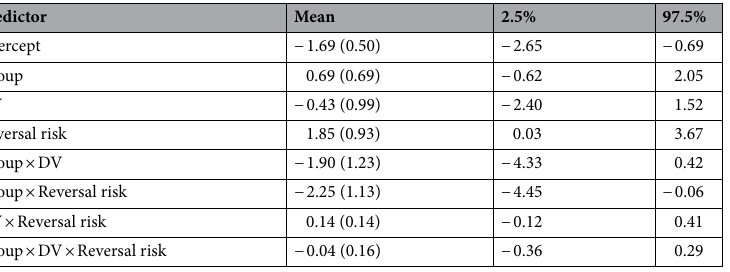
Table 4. Results of Bayesian MGLM in the precommitment task, regressing precommitment choices (0 = no precommitment, 1 = precommitment) on predictors for Group (0 = nonsmoker, 1 = smoker), difference in value (DV), reversal risk (DV in 28 days minus DV now), and the interaction terms. We report the upper and lower borders of the 95% HDI of the posterior distributions. Standard errors of the mean are in